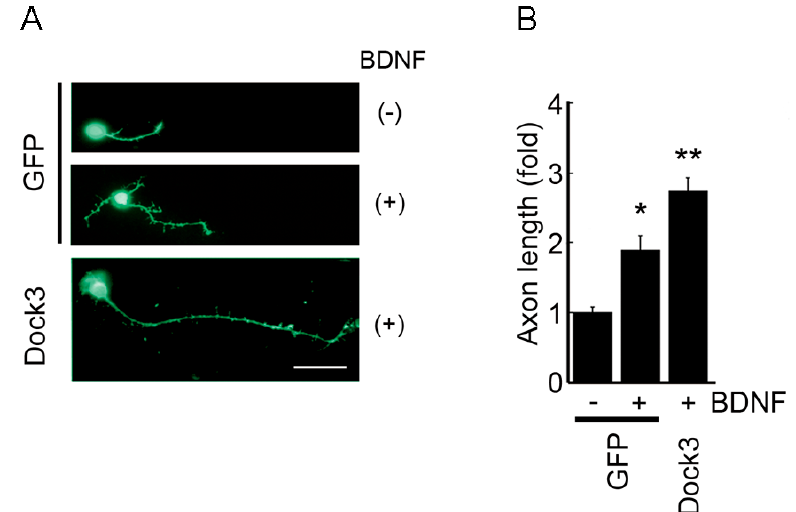
Figure 1. Dock3 enhances BDNF-mediated axonal elongation. ( A ) Retinal ganglion cells were cultured in the presence or absence of BDNF for 3 days. When Dock3 is overexpressed, the BDNF-induced neurite outgrowth is remarkably enhanced (Dock3). Scale bar, 20 µ m; GFP, green fluorescent protein; ( B ) Quantification of ( A ). n = 50 for each experimental condition. Data are mean ± SEM of three independent experiments. * p < 0.05, ** p < 0.01. Modified from Namekata et al., Proc.